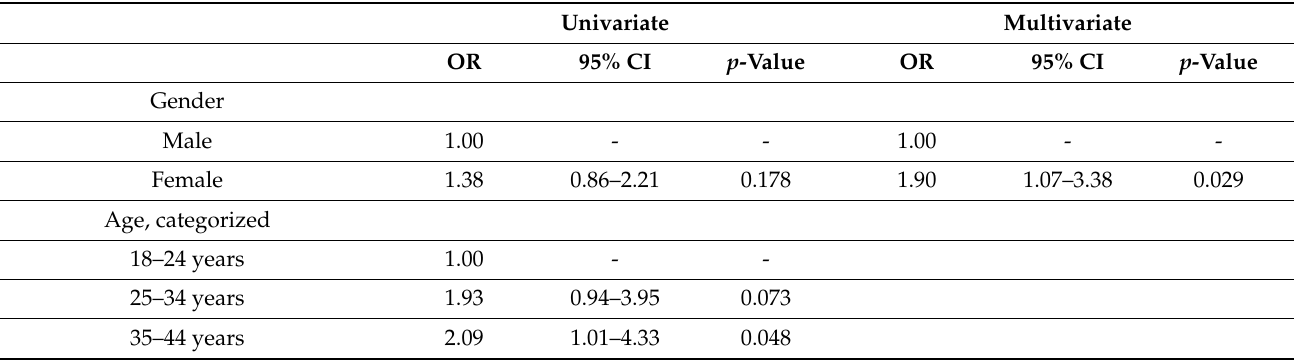
Table 3. Univariate and multivariate logistic regression, odds of hypertension among Ukrainian